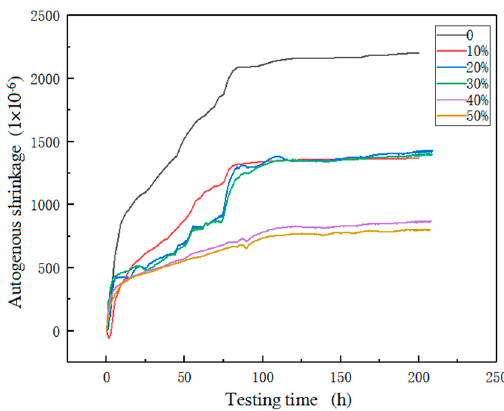
Figure 11. The early autogenous shrinkage curve of recycled brick micropowder UHPC.